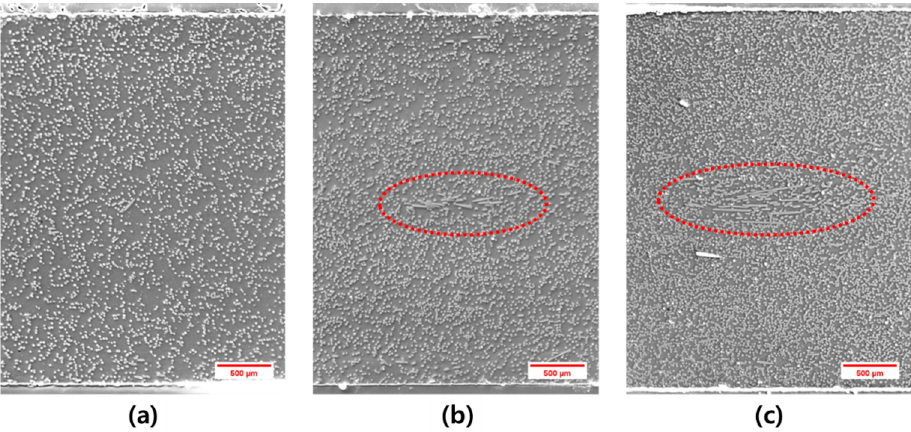
Figure 2. The cross-section images of GF/mPPO composites (the scale bar is 500 μ m); ( a ) GF/mPPO 30, ( b ) GF/mPPO 40, and ( c ) GF/mPPO